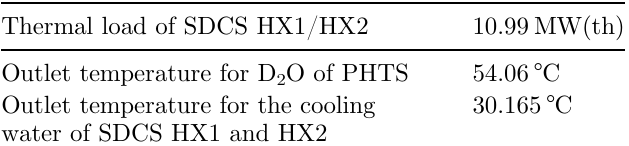
Table 4. Thermal analysis. Model III.